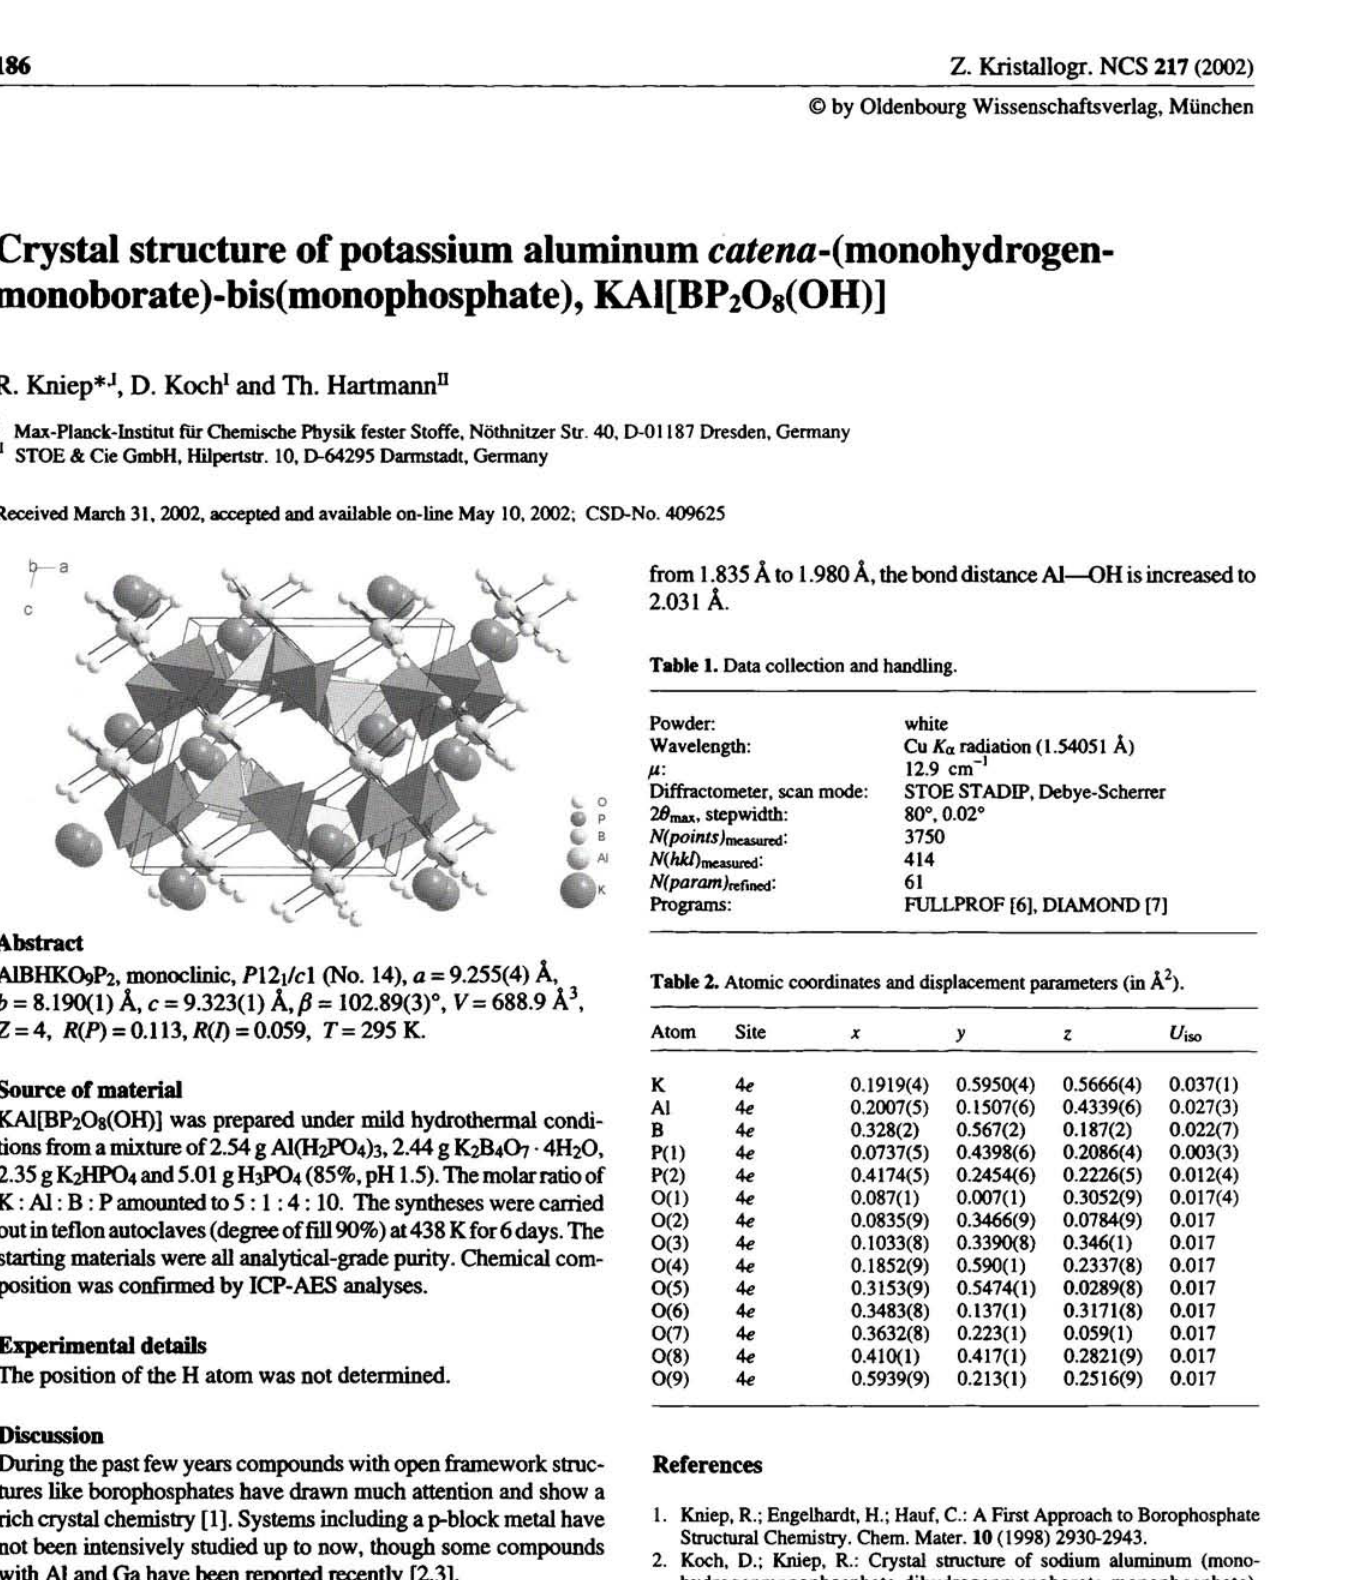
Table 2. Atomic coordinates and displacement parameters (in Â 2